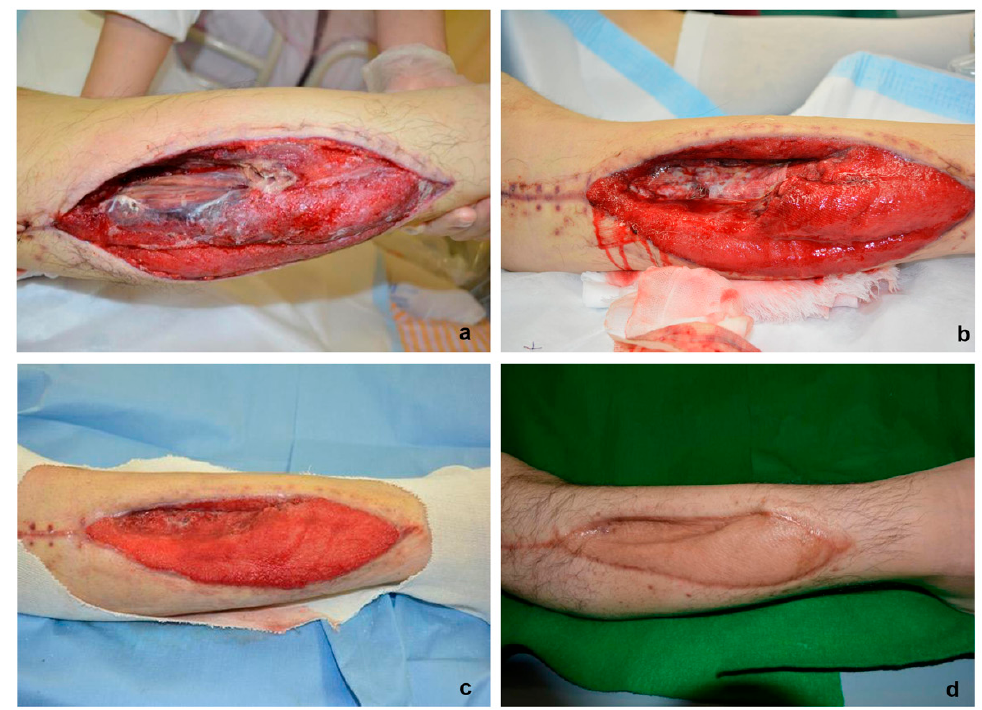
Figure 2. Eight days after emergency incision for the relief of lower leg compartment syndrome. The wound reached the interosseous membrane, and necrotic tissue was observed in its vicinity ( a ). Three weeks after the wound management with negative pressure wound therapy (NPWT). Still being deeply graved, the wound was complemented with micrografts treatment using Rigenera technology ( b ). In just two weeks, the wound was covered with good granulation, and meshed skin graft was performed ( c ). Six months later from the skin graft we observed 100% of graft intake ( d ).